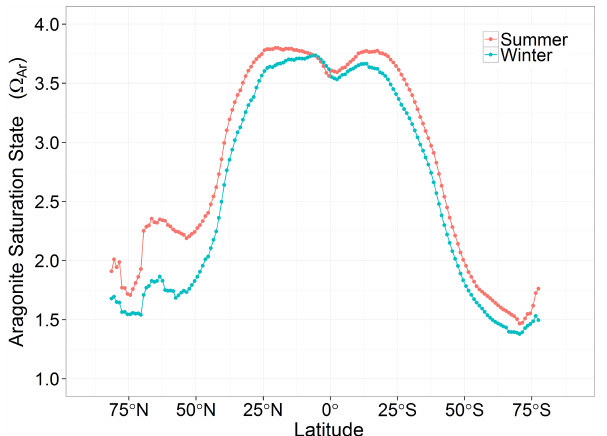
Figure 2. Zonal mean (cid:127) Ar predictions for winter and summer. Summer and winter months were defined as June through to August and December through to February for the Northern Hemisphere respectively, while Southern Hemisphere differed by 6